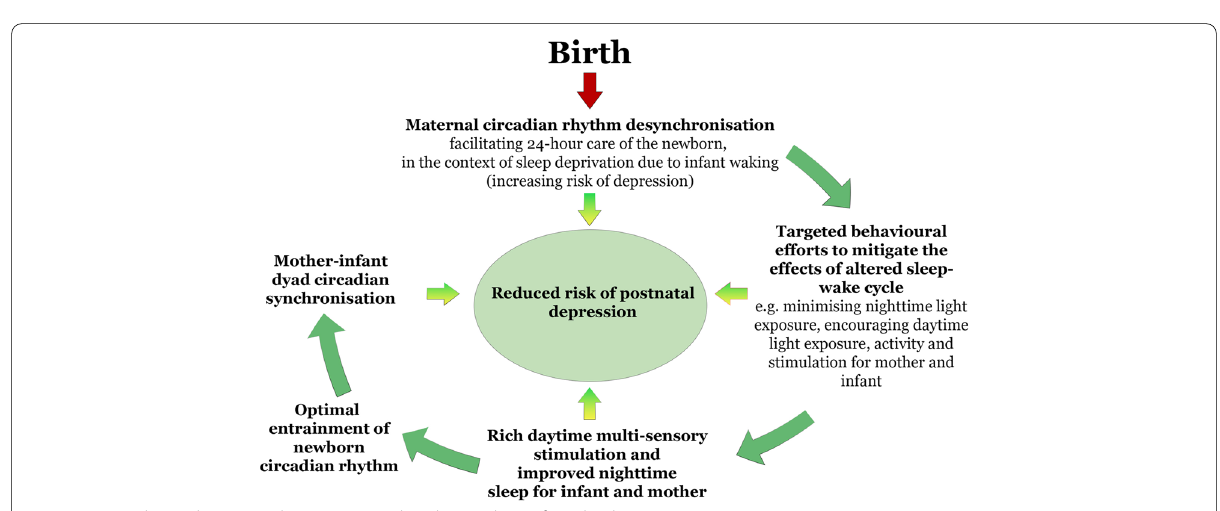
Fig. 2 Optimal circadian resynchronisation within the mother-infant